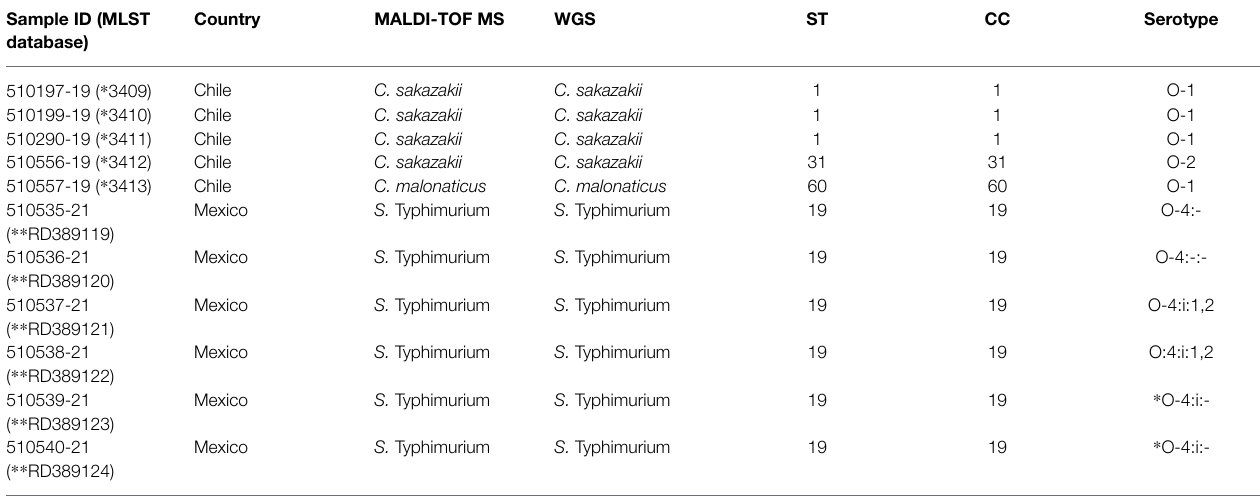
TABLE 1 | Identification of Cronobacter spp. and Salmonella spp. strains isolated from powdered infant formula by matrix-assisted laser desorption ionization time-of- flight mass spectrometry (MALDI-TOF MS) and whole-genome sequencing (WGS). Sample ID (MLST Country MALDI-TOF database)